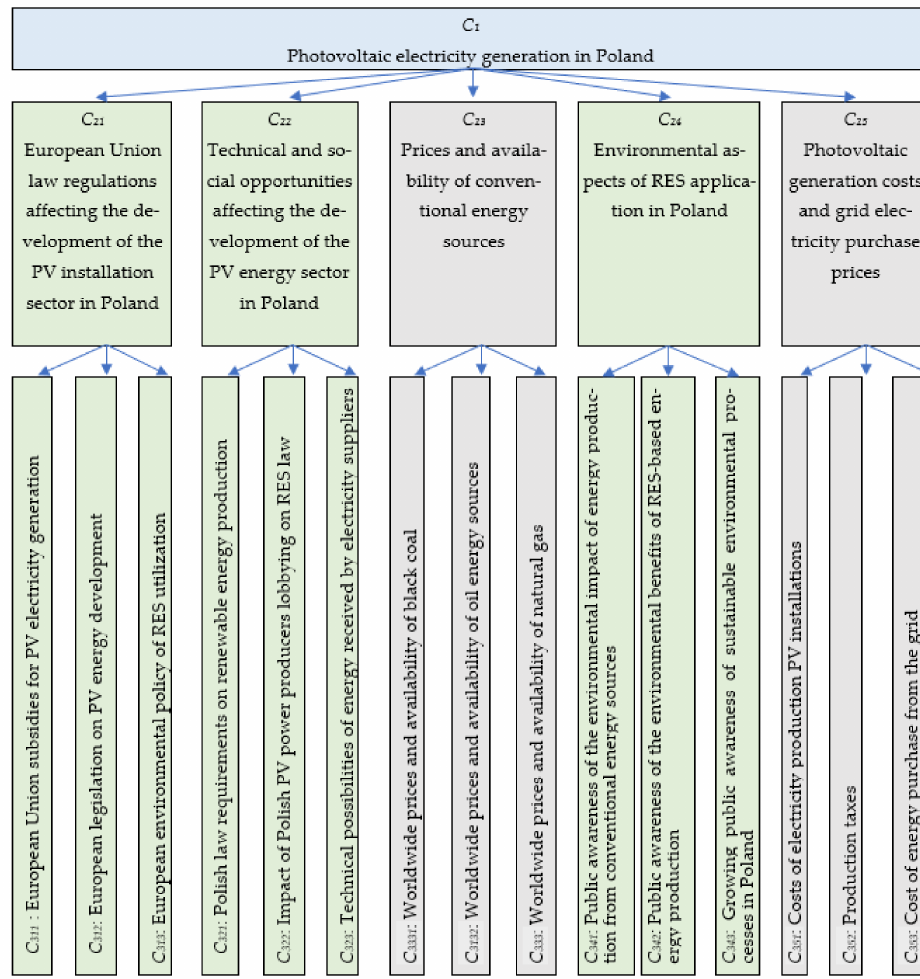
Figure 2. Input elements for the event tree analysis (ETA) assessing the main criteria (C) necessary for the cost-effectiveness of energy production in small PV systems in Poland. The presented tree shows a top-down, inductive procedure structuring the energy production possibilities in main social or economic factors. C 1 is the initial event engaging energy production possibilities in small PV systems; C 2X is the level of factors assessing the various elements with potential economic and social influence on energy production from small PV systems; C 3X is the level of factors assessing the cost,